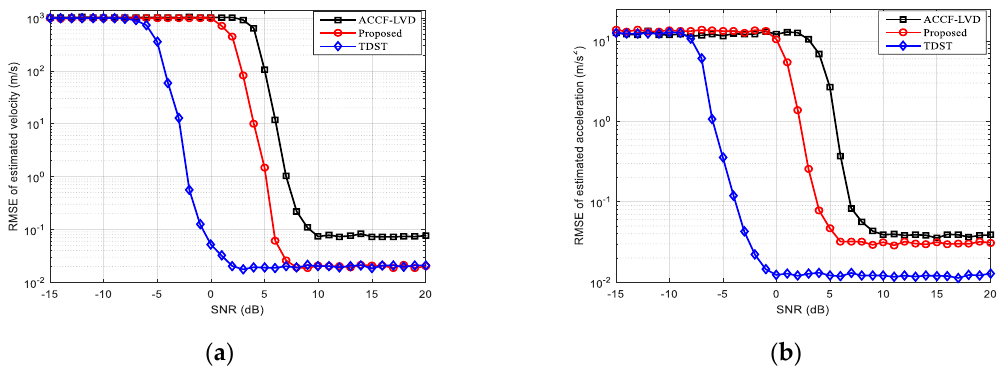
Figure 9. Motion parameters estimation performance of the three methods. ( a ) Estimation of the root mean square error (RMSE) of velocity; ( b ) estimation RMSE of acceleration.